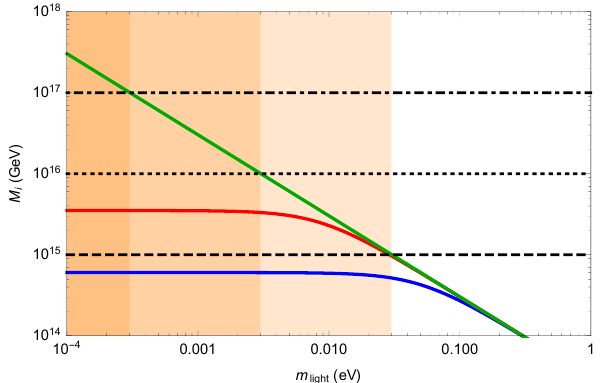
Figure 1 . Pro(cid:12)les of the RH neutrino masses as a function of the lightest active neutrino mass m light . The blue (red) [green] continuous line corresponds to the lightest (next-to-lightest) [heaviest] RH neutrino. The horizontal lines represent di(cid:11)erent values for the lepton number violation scale: the dashed one refers to (cid:22) = 10 15 GeV, while the dotted to (cid:22) = 10 16 GeV, and the dot-dashed to (cid:22) = 10 17 GeV. The shaded areas are regions where the condition ( ^ Y M ) ii (cid:20) 1 does not hold: three speci(cid:12)c cases are illustrated for (cid:22) L = 10 15 GeV, 10 16 GeV, 10 17